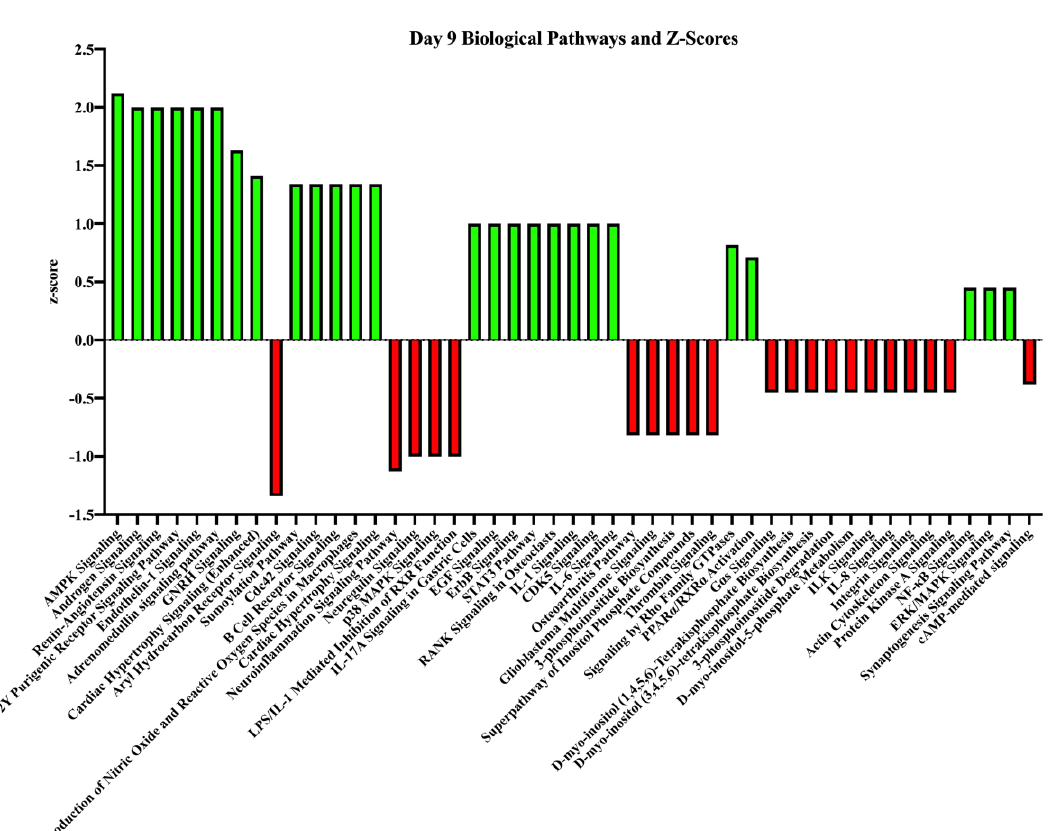
Figure 3. Top biological processes and z-scores on day nine in endometrial samples from pregnant and non-pregnant mares. These are the biological processes associated with the genes of higher abundance in the given pregnancy status on day nine. The z-score indicates the association strength with activating (green bars) or inhibiting (red bars) a pathway due to the sample being obtained from a pregnant mare.